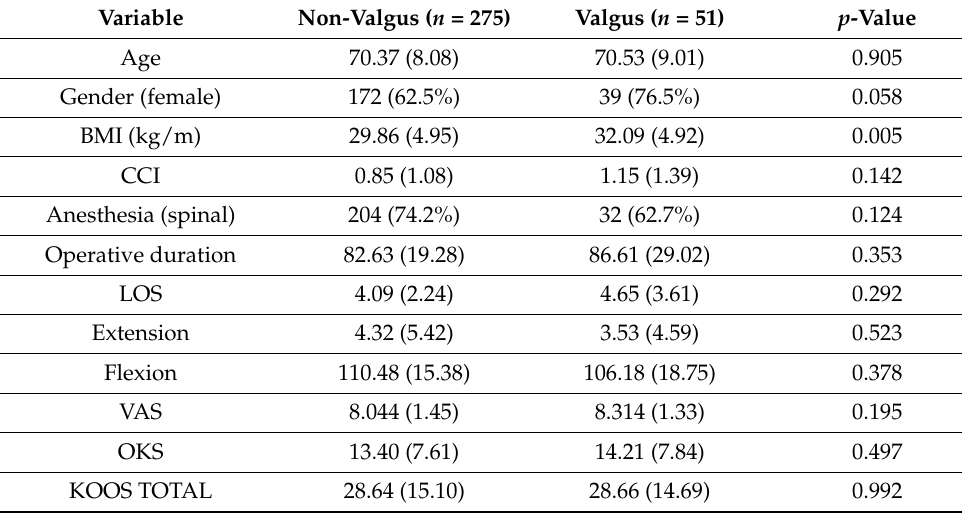
Table 1. Baseline characteristics, operative factors, and patient reported outcomes in the valgus versus non-valgus